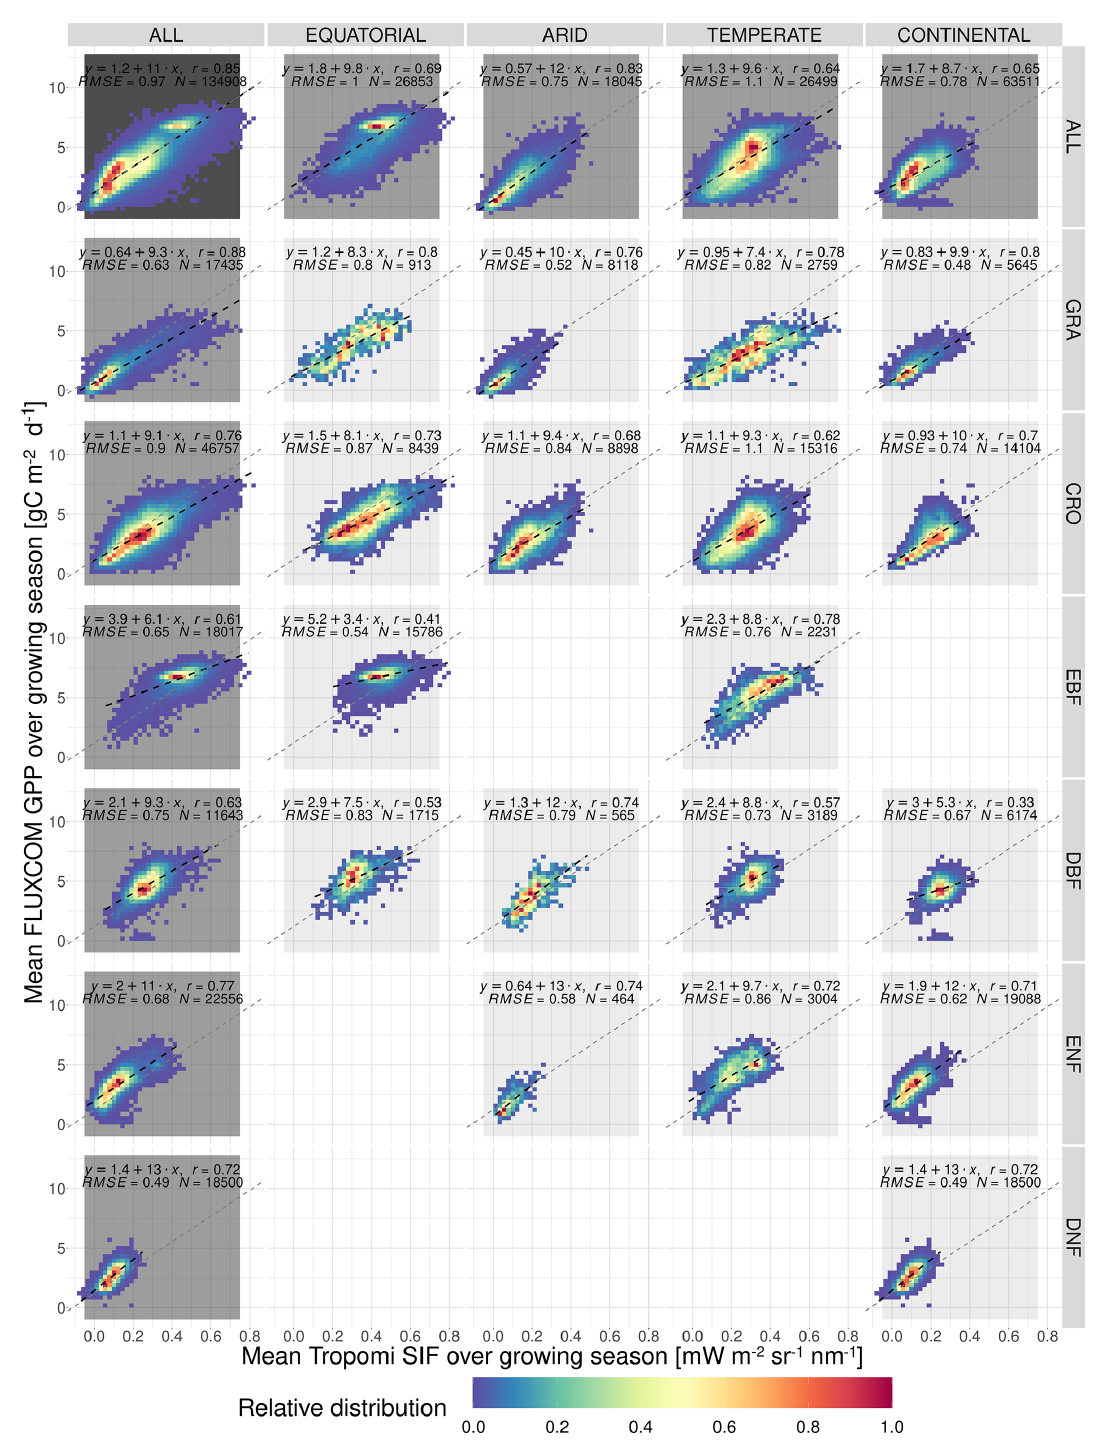
Figure A7. The spatial relationship between the mean growing-season TROPOMI SIF and FLUXCOM GPP, broken down into separate Köppen–Geiger climate zones and vegetation cover categories. The plot shows the frequency distribution of pixels into SIF DS –GPP FX bins, relative to the highest-frequency bin in that category. A dashed black line representing a linear model in each category is overlaid and compared to a dotted grey line representing a linear model produced without the breakdown into separate categories (i.e. ALL–ALL). The linear model equation, correlation coefficient r , root mean square error (RMSE) and number of pixels are